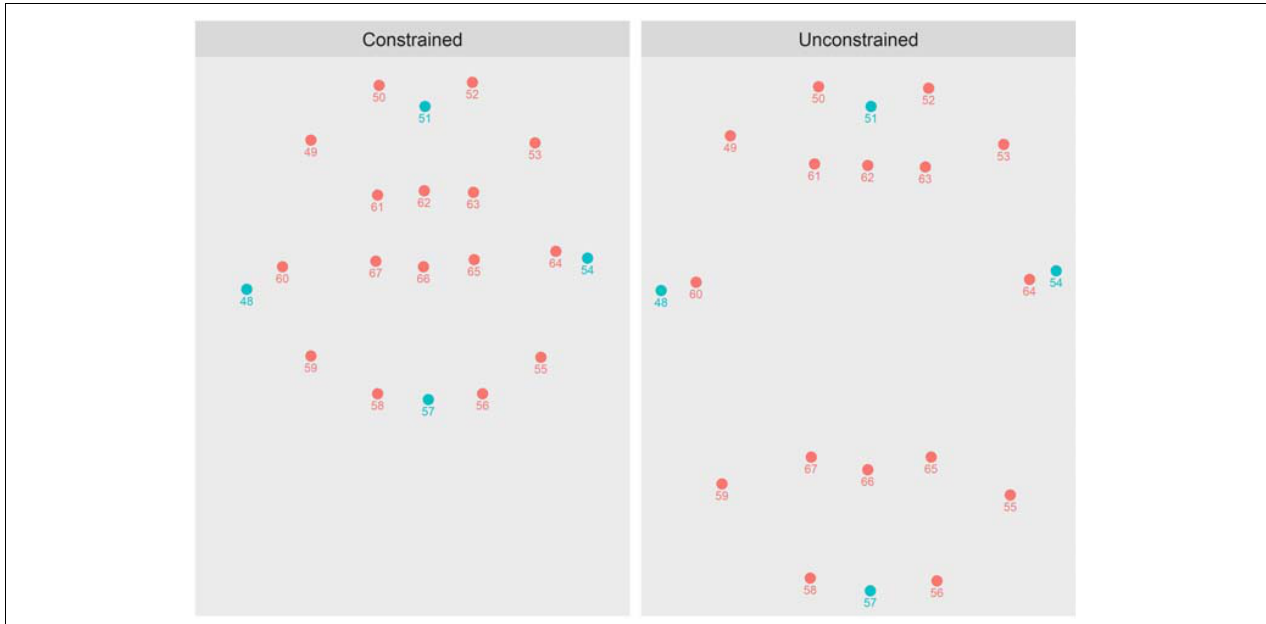
FIGURE 1 | Plots of OpenFace parameters 48–67, which track the outer and inner lips, as arrayed on two frames of real facial video, each capturing the moment of acoustic onset for a different word. (Left) The first author beginning the word “oodles,” a constrained word. (Right) The first author beginning the word “apple,” an unconstrained